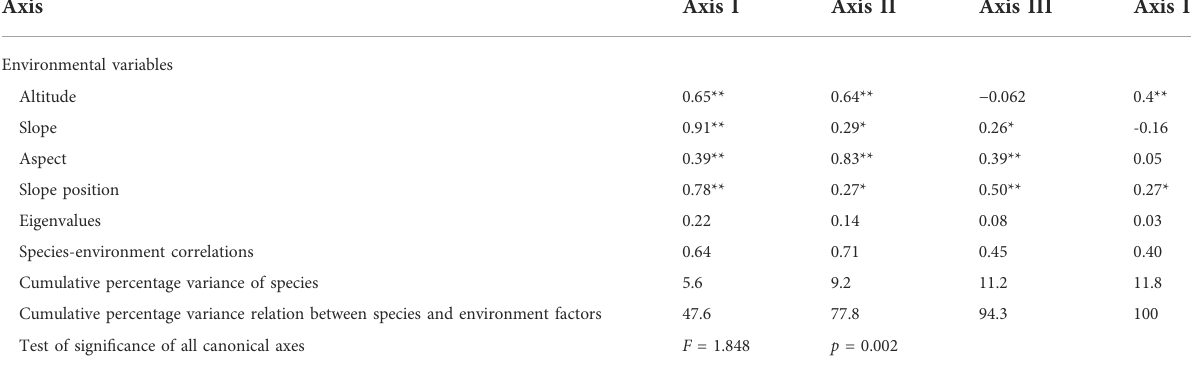
TABLE 3 The CCA analysis of the species variance of sandy alpine grassland communities. Axis